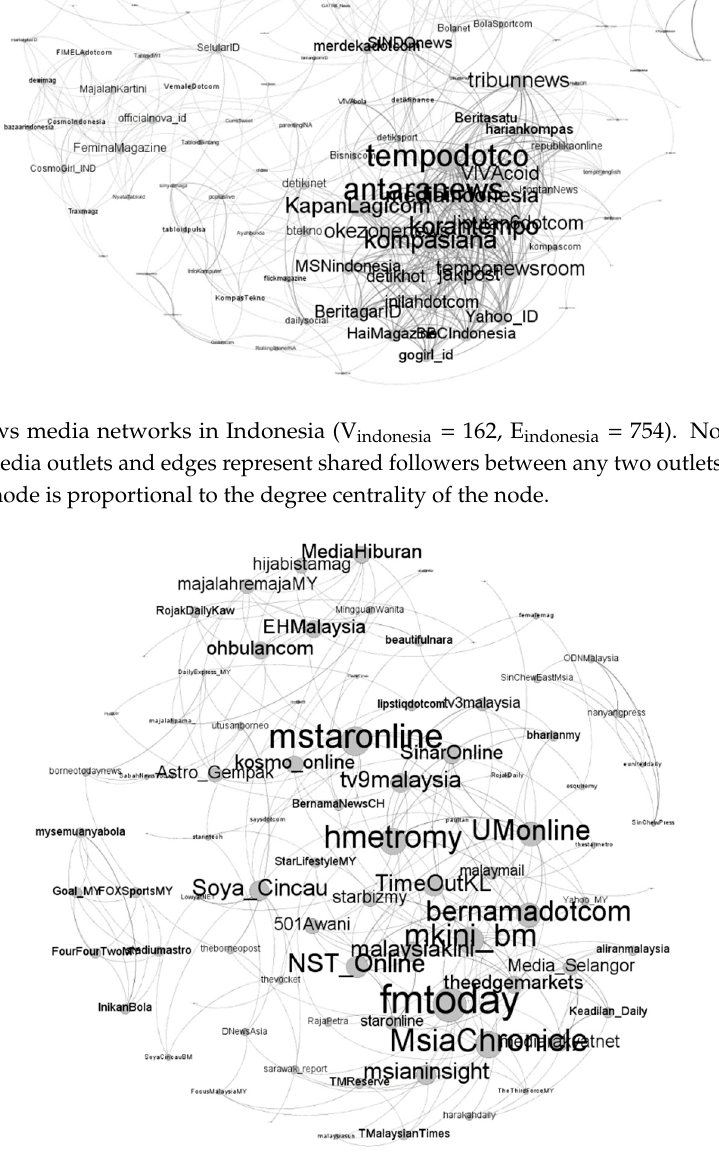
Figure 5. News media networks in Malaysia (V malaysia = 86, E malaysia = 227). Nodes represent online news media outlets and edges represent shared followers between any two outlets. The size and the label of a node is proportional to the degree centrality of the node